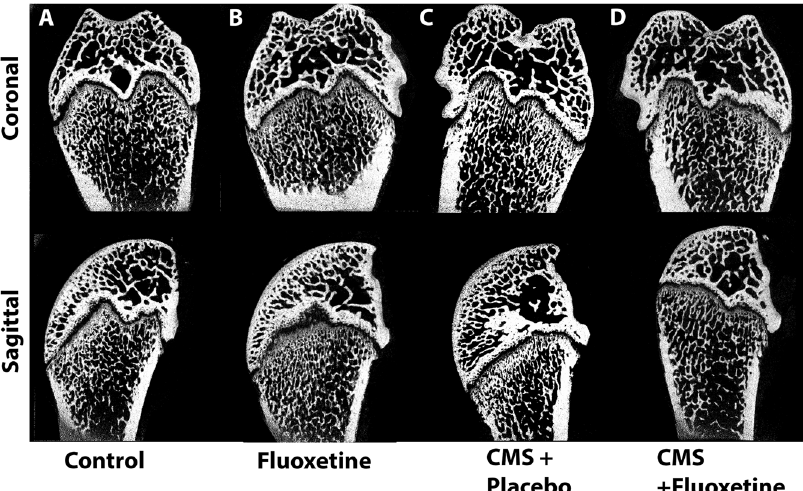
Fig. 3 Representative micro computed tomography ( μ CT) 2D longitudinal sections of rat femurs. A Control, B fl uoxetineonly, C CMS + placebo, and D CMS + fl uoxetine